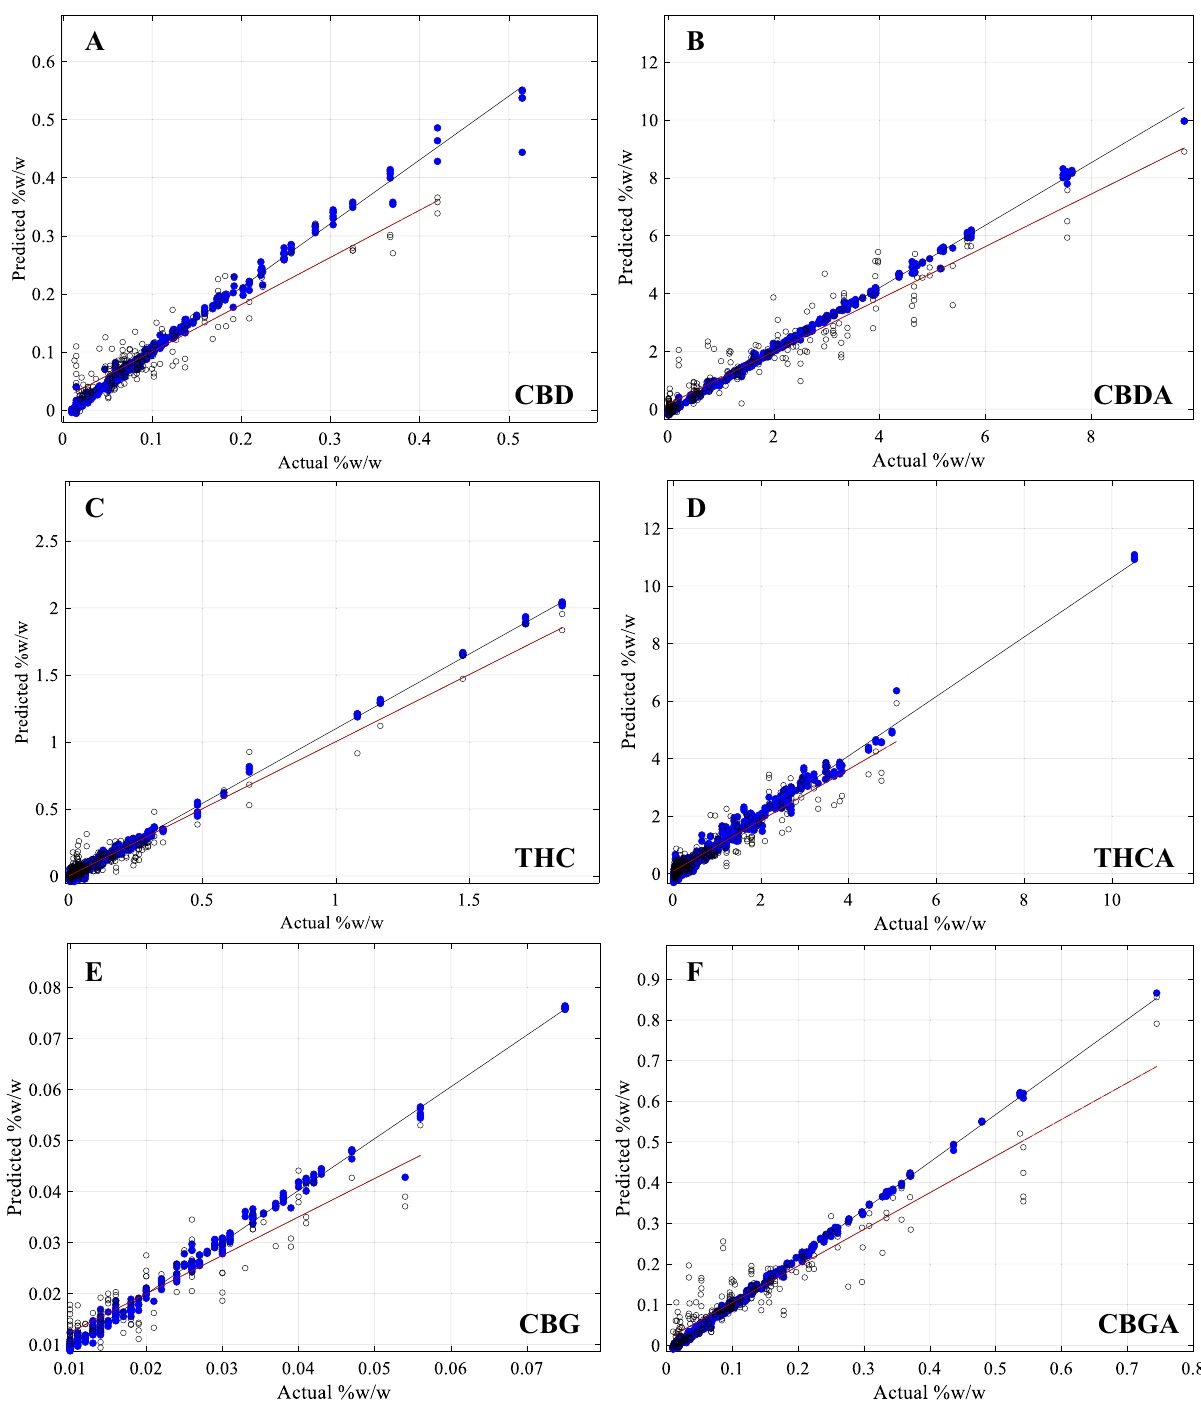
Figure 4. Cross-validation and Hold-out validation results for all 12 target cannabinoids. Actual values were obtained via HPLC reference method, predicted values were obtained from scans using the HL-EVT9-Neo NIR spectrometer, modelled using the Hone Create chemometric platform. Root mean square error and r 2 values are given in Table 1. Cross-validation (CV), blue closed circles and black trend-line and Hold-out validation (HV), open circles and red-trend line results for the 12 target Cannabinoids: ( A ) Cannabidiol (CBD) ( B )